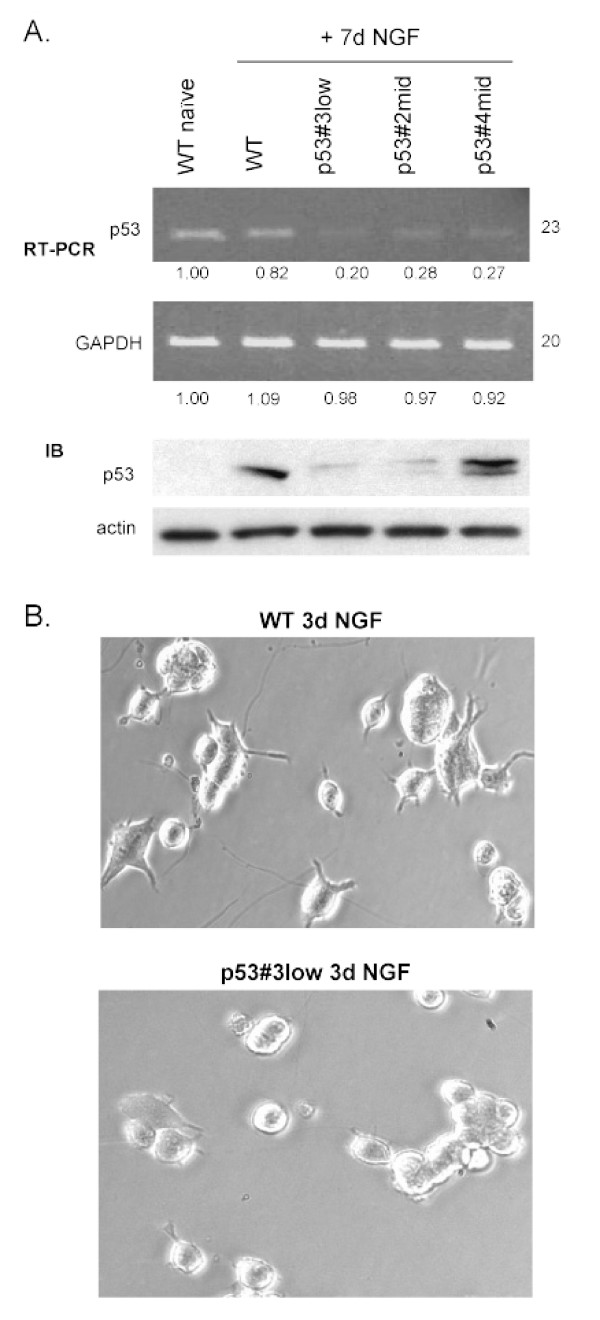
Analysis of p53 knockdown PC12 cell lines. A) RT-PCR and immunoblot depicting levels of p53 mRNA and protein in wild-type naïve PC12 cells compared to 7-day NGF (50 ng/mL) differentiated wild-type and anti-p53 shRNA expressing PC12 cells. GAPDH mRNA levels serve as loading control for RT-PCR, while actin serves as immunoblot loading control. p53 and GAPDH mRNA levels in each sample were quantitated using ImageJ and normalized to naïve RNA levels, depicted under each band. PCR cycle number used is shown on right of gel image. p53 RNA and protein levels (and knockdown efficiency) were lowest in p53#3low cells, followed by p53#2mid and p53#4mid cell lines. B) Representative image of wild-type and p53#3low PC12 cells following 3 days treatment with 50 ng/mL NGF.